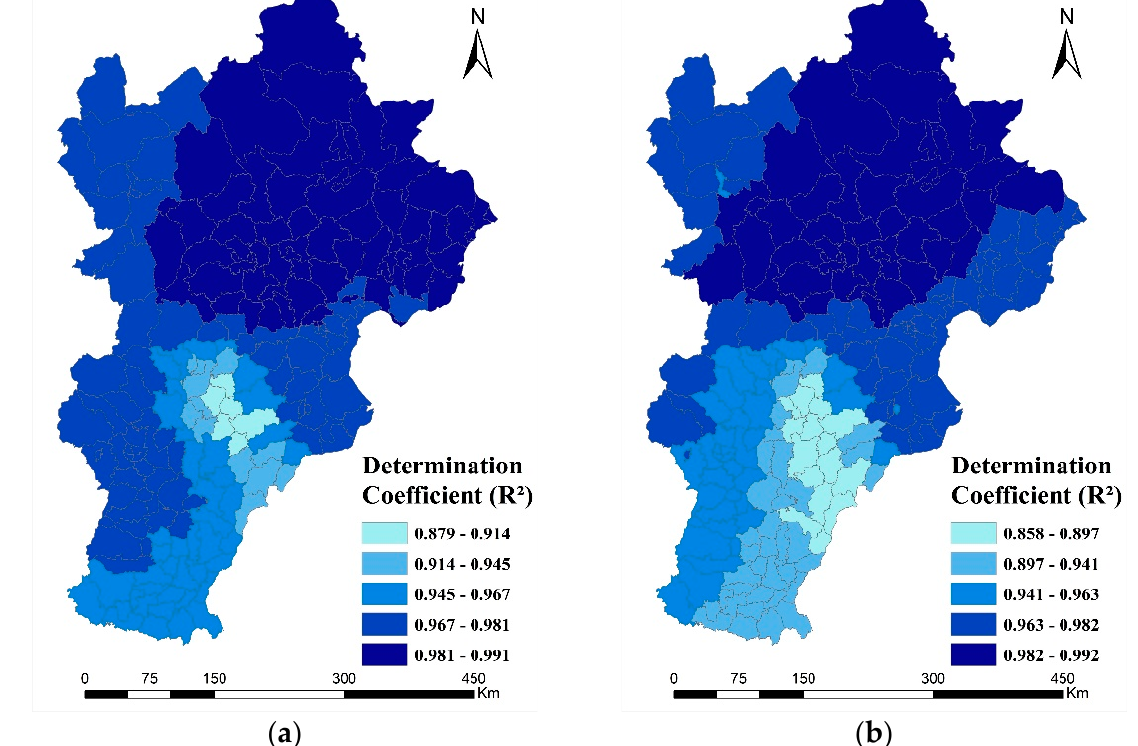
Figure 4. Spatial distribution of the coefficients of determination of the MGWR model. ( a ) 2010, ( b ) 2018.